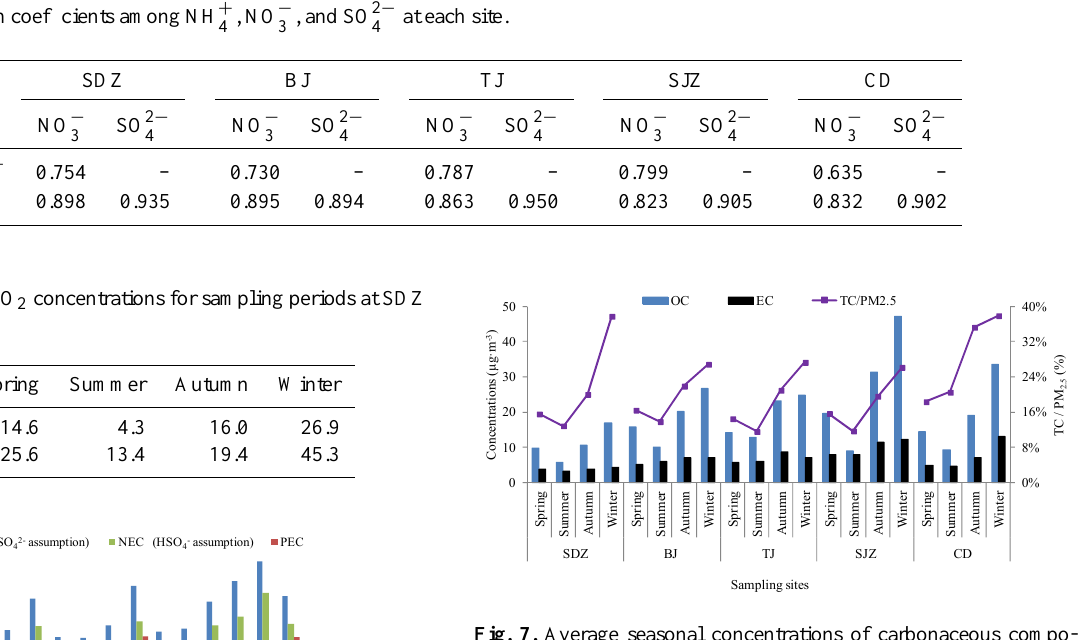
4 and SO 2 − (NEC). 3 4